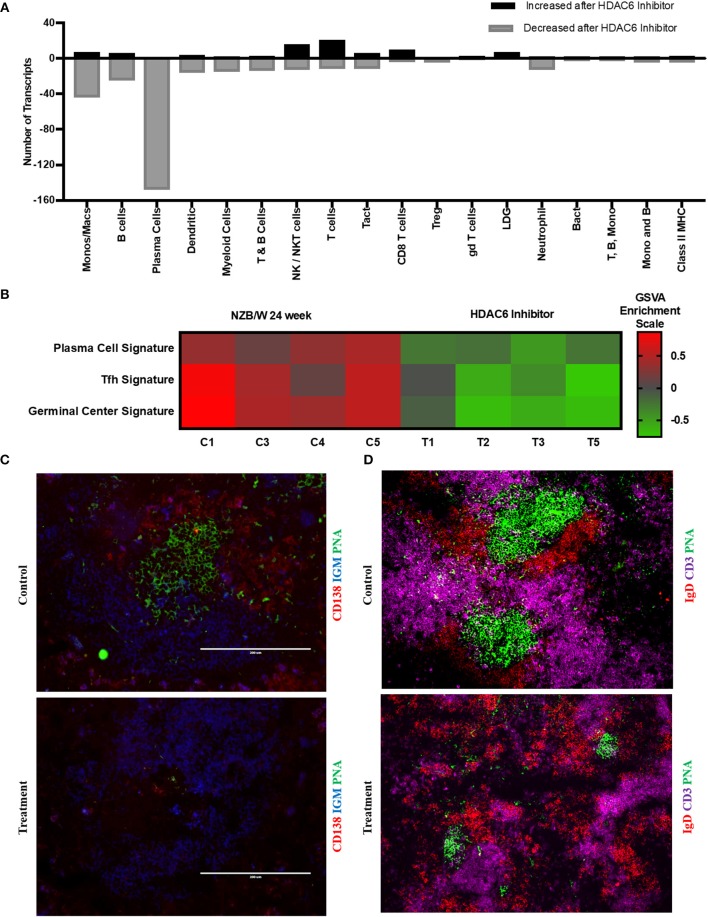
HDAC6i treatment results in significantly decreased GC activity and PC formation. (A) I-Scope hematopoietic cell enrichment demonstrated that HDAC6 inhibition decreased PC, B cells and inflammatory myeloid cells. The number of transcripts corresponding to each cell type increased or decreased after HDAC6 inhibitor treatment are shown. Gene symbols for transcripts for PC, B cells and inflammatory myeloid cell are in Supplementary Data 1 (increased transcripts) and Supplementary Data 2 (decreased transcripts). (B) GSVA was carried out to determine the enrichment of PC, Tfh cells and GC in each HDAC6 inhibitor treated and control NZB/NZW mouse (Methods lists genes used for GSVA enrichment modules). (C) Representative splenic section stained with anti-CD138, anti-IgM and PNA. (D) Representative splenic section stained for T cells, follicular B cells and GC with anti- CD3, anti-IgD, and PNA.